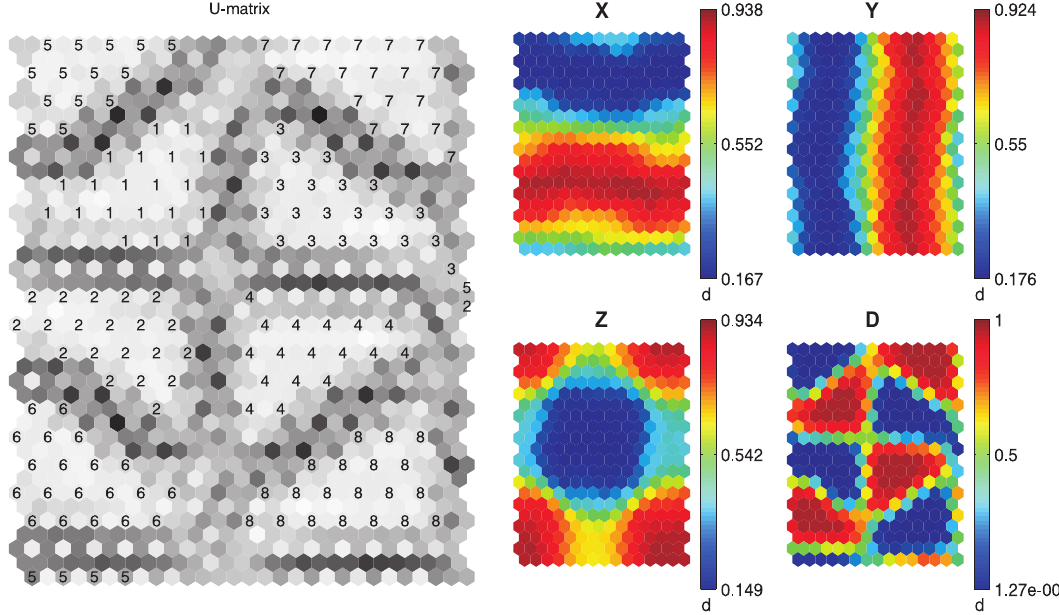
Fig. 4. U-matrix (left) and component planes (right) of the standard GEO3DSOM-analysis of the theoretical data set. distribution of variable D is shown in Fig. 2. This distribution results in 8 pre-defined groups (Table